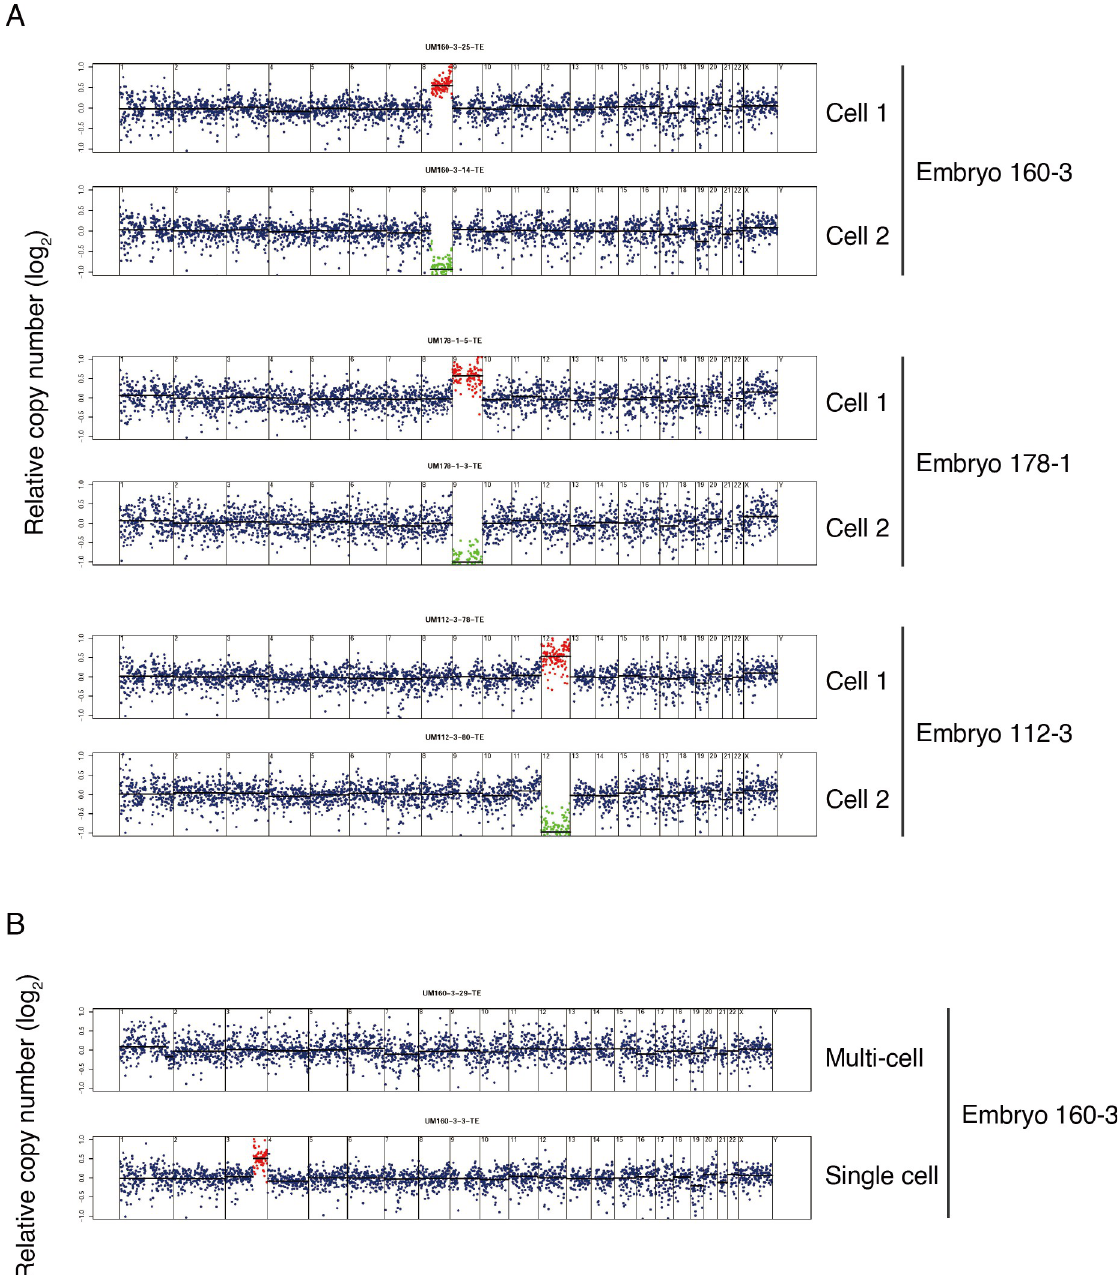
Fig 4. Single cell whole genome sequencing identified chromosome gain and loss which is missed in multi-cell TE sequencing. A) Segmentation plots showing matched chromosome gain and loss at single cell level. Segmentation plots showing copy number of single cells relative to a euploid reference on a log2 scale. Segments above threshold for gain are colored in red, segments below threshold for loss are colored in green. B) Segmentation plots showing chromosome copy number of multi-cell (top) and corresponding single cells (bottom). The multi-cell sample showed euploidy but the corresponding single cell showed a segmental chromosome